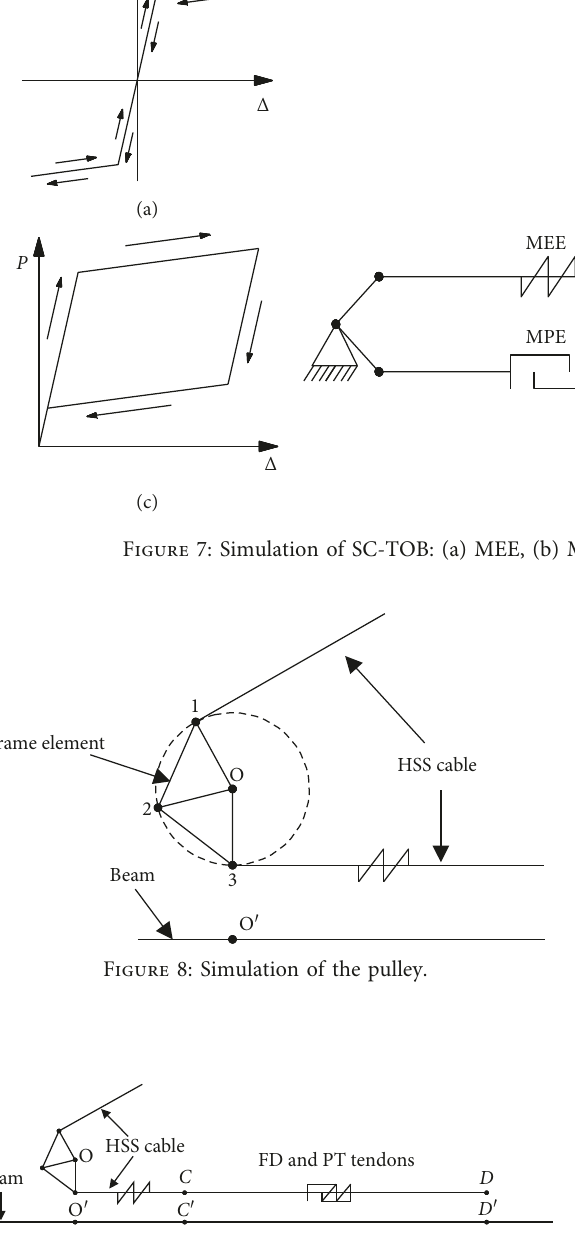
Figure 9: Combination of elements for SC-TOB